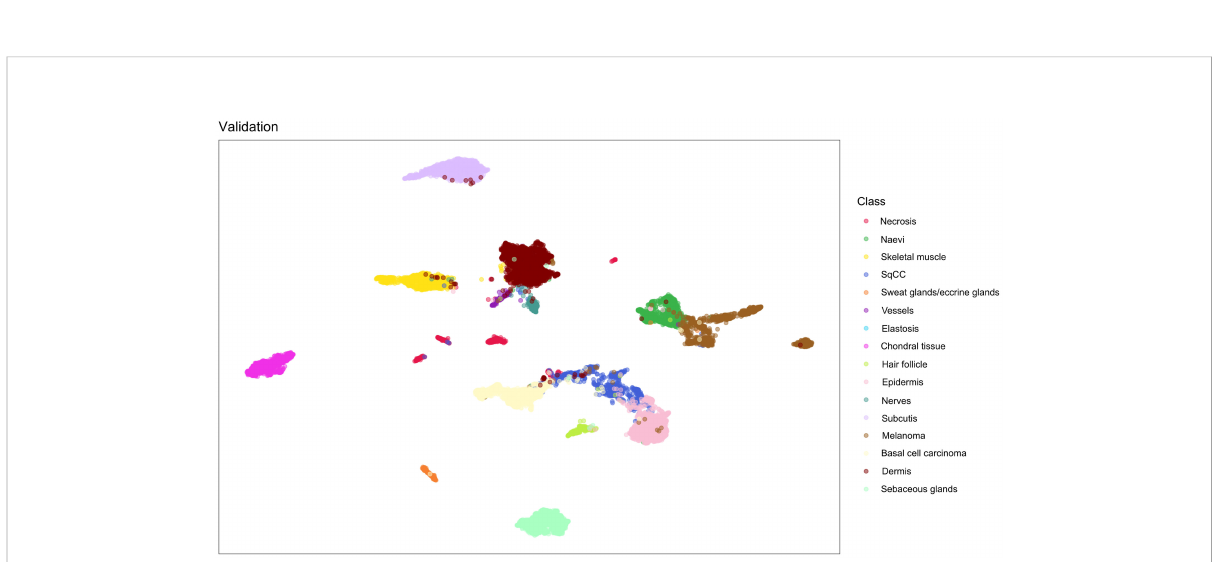
FIGURE 5 Dimension reduction using uniform manifold approximation and projection based on the last convolutional layer after the last pooling operation of the validation data. Close proximity of image classes that resemble each other morphologically such as melanocytic tumors can be observed. On the other hand, image categories that are morphologically very different such as skeletal muscle, sebaceous glands or chrondral tissue show distinct clusters. BCC, basal cell carcinoma; SqCC, squamous cell